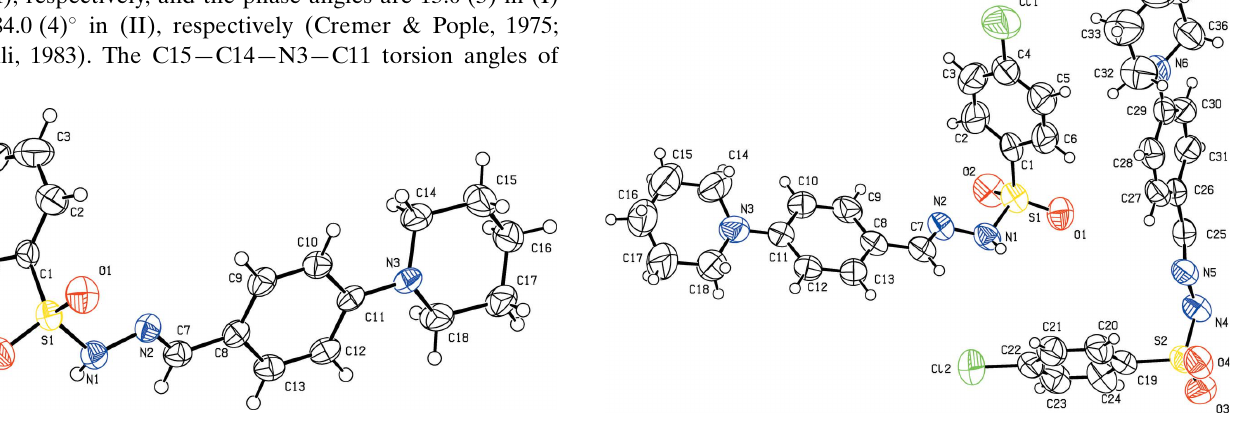
Figure 3 Molecular structure of (III), showing the atom labelling and displacement ellipsoids drawn at the 50% probability level.